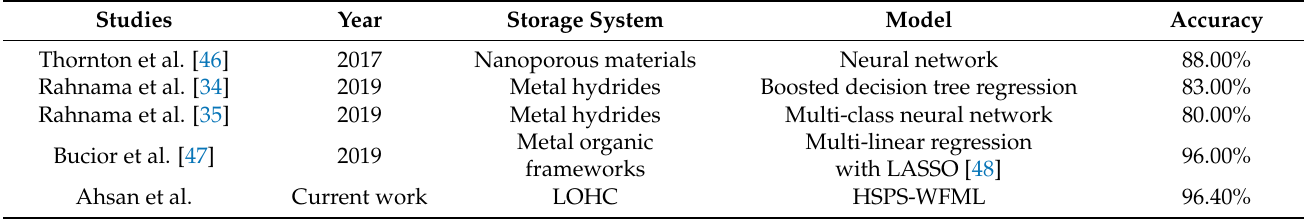
Table 4. Comparison of the current study with previous